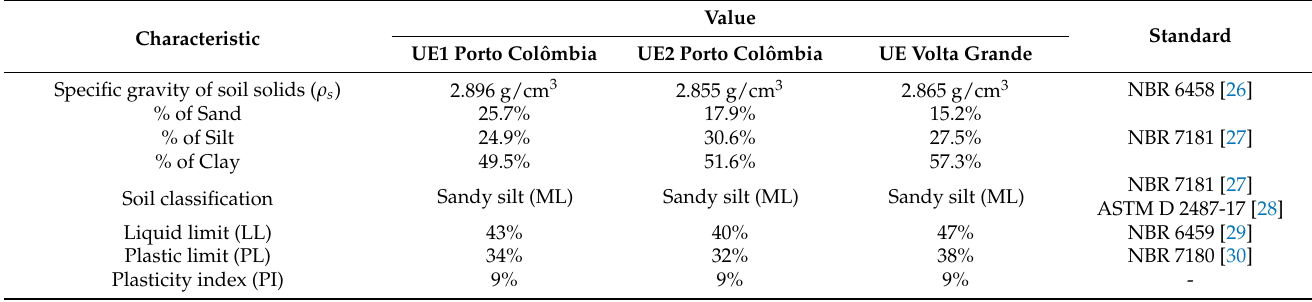
Table 1. Geotechnical characteristics of the experimental